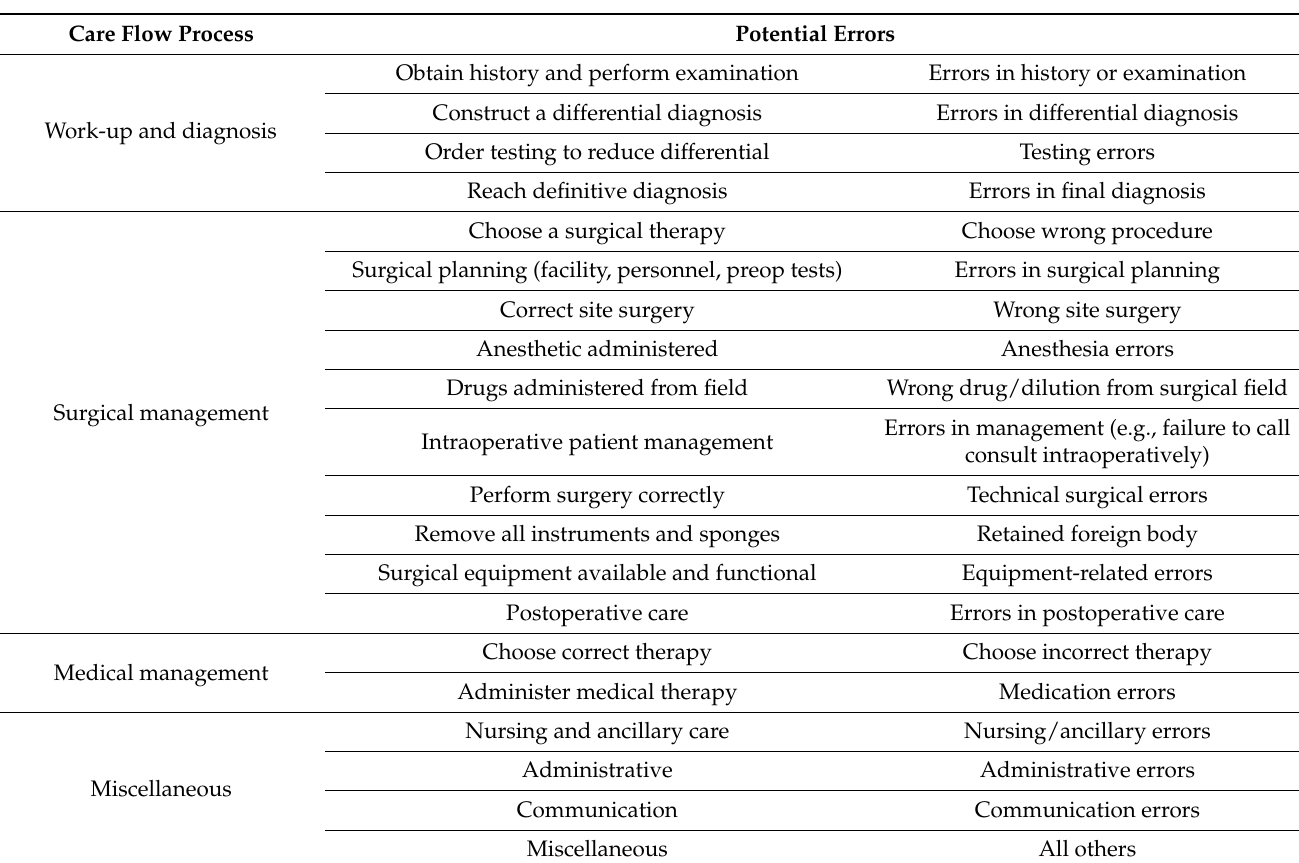
Table 2. The idealized care flow and potential errors [58]. Reprinted with permission from Ref. [58]. 2004 Wiley Online